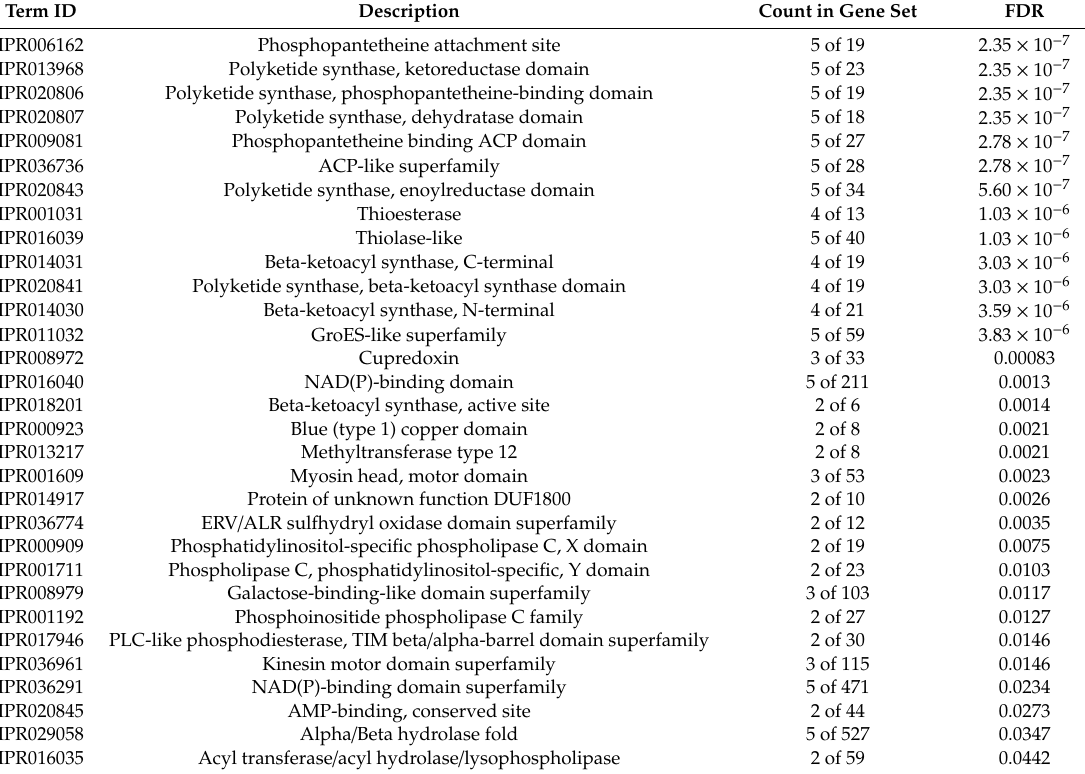
Table 2. The enriched domains of upregulated DEGs in the Interpro